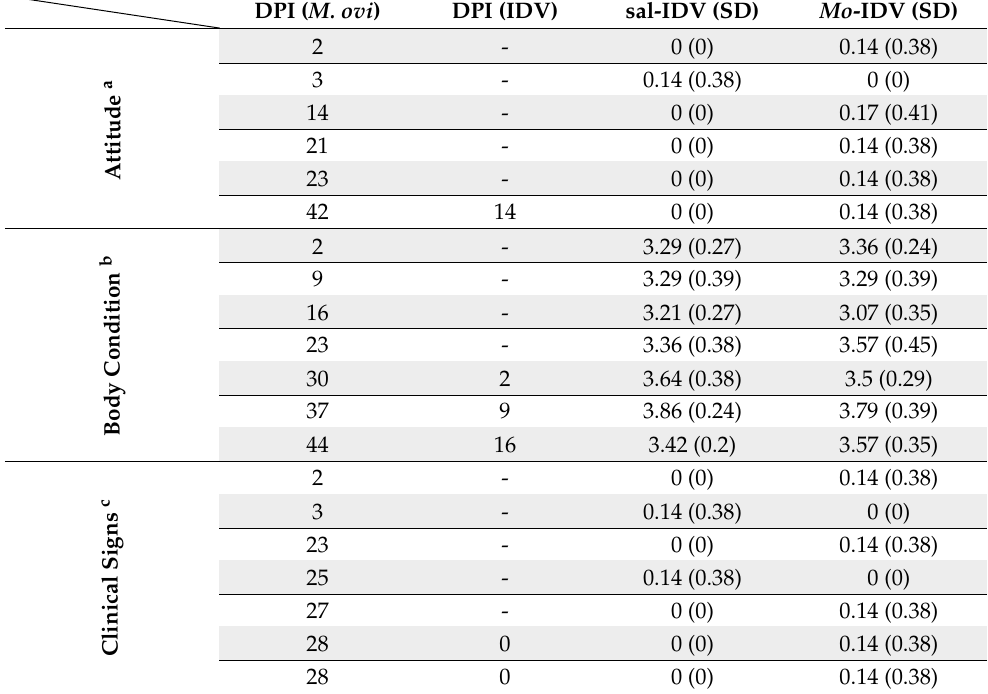
Table 1. Clinical parameters from each group at indicated